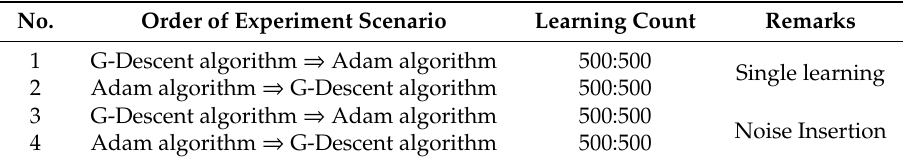
Table 5. Test result comparison with three algorithms of machine learning.